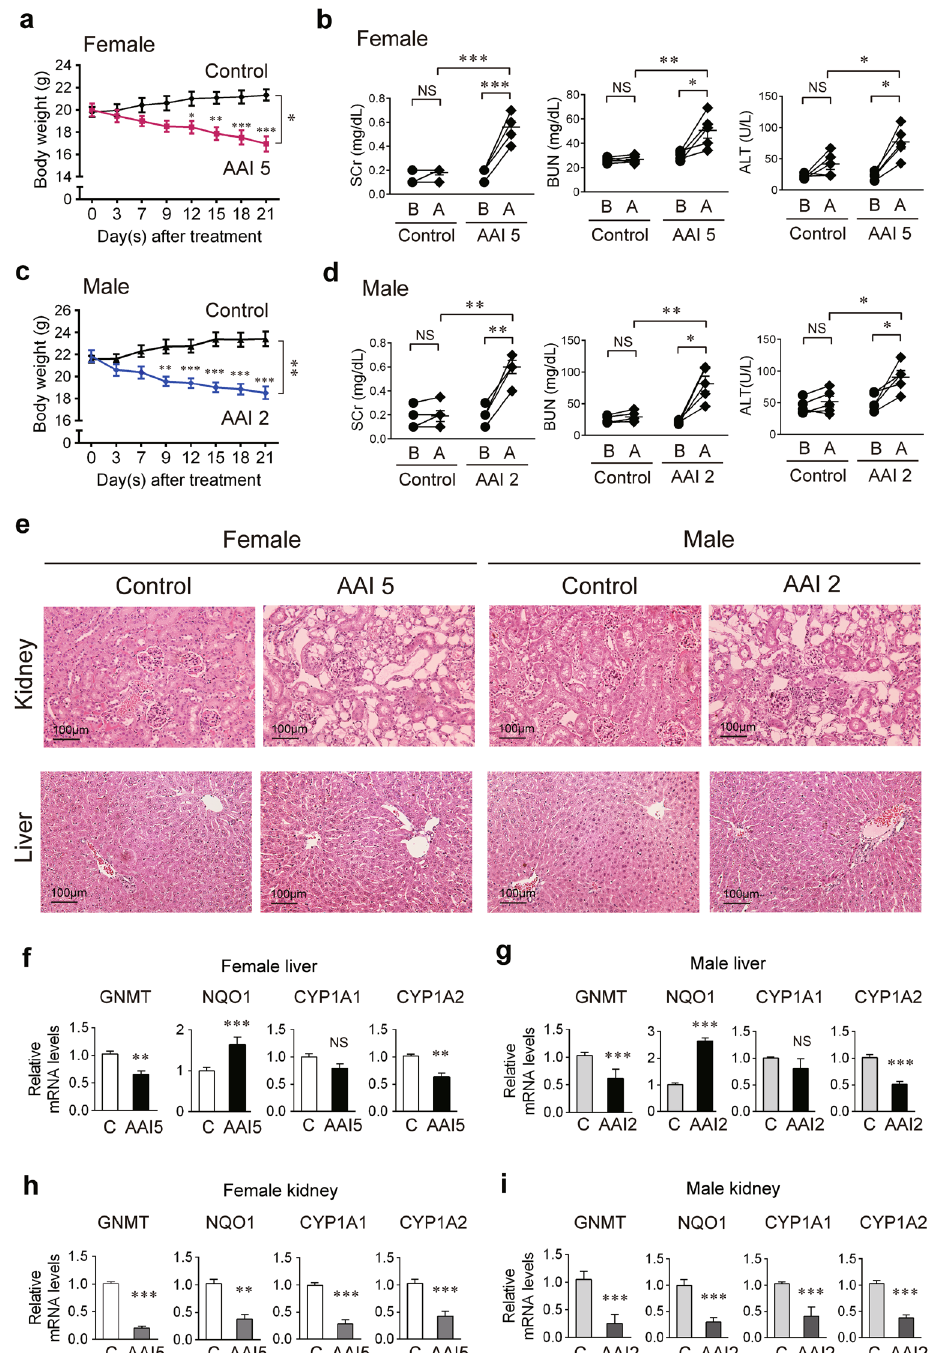
Figure 1. GNMT participates in the metabolism of AAI. ( a,c ) Body weight (BW) of wild-type (WT) C57BL/6 mice intraperitoneally injected with 2 or 5 mg/kg BW/day AAI (AAI 2 or AAI 5) or corn oil (vehicle control), 5 days/week for 3 weeks. Values presented are mean ± SEM, n = 5. p -values were calculated by two-way ANOVA and Sidak’s multiple comparisons test. ( b , d ) The serum levels of alanine aminotransferase (ALT), creatinine (SCr) and blood urea nitrogen (BUN) were measured from mice at the day before (B) and after (A) the 3-week AAI treatment. The biochemistry parameters from the same mouse before and after AAI- treatment were analyzed by Paired t -test. p -values for the comparison of biochemistry parameters from AAI- and corn oil-treated mice were calculated by Student’s t -test. ( e ) Histological examination of the kidney and liver tissue in AAI- and corn oil-treated WT mice (hematoxylin and eosin stain, original magnification × 200). ( f–i ) mRNA levels of Gnmt, Nqo1, Cyp1A1, Cyp1A2 genes in the livers ( f , female liver; g , male liver) and kidneys ( h , female kidney; i , male kidney) from AAI- or corn oil-treated WT mice were determined by qPCR. Data were normalized to β -actin. All values are presented as the mean ± SEM, n = 5. p -values were calculated by Student’s t -test. * p < 0.05, ** p < 0.001, *** p ≤